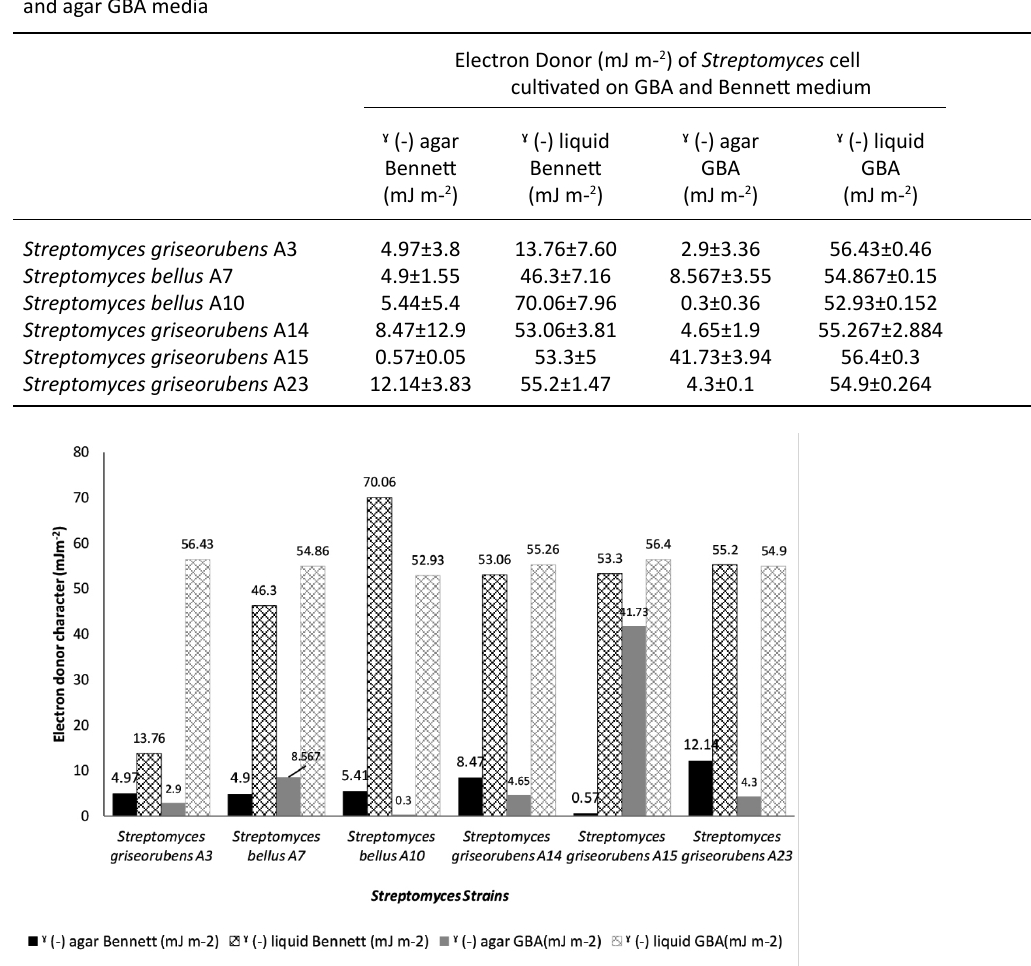
Fig. 2. Electron donor character (ˠ (-) in mJm-2) of Six Streptomyces strains cultivated on Bennett liquid, agar Bennett, GBA liquid and agar GBA